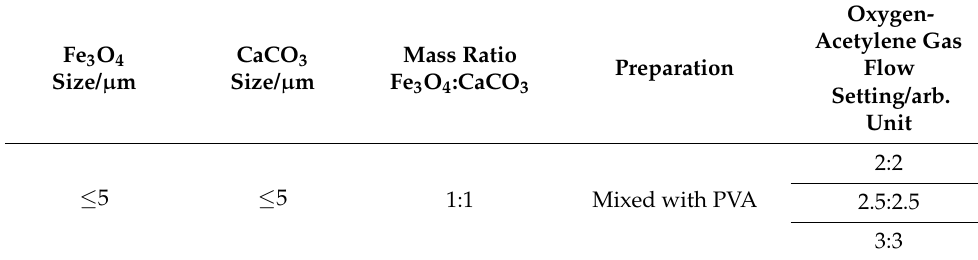
Table 9. Parameters to evaluate the effects of gas flow setting.